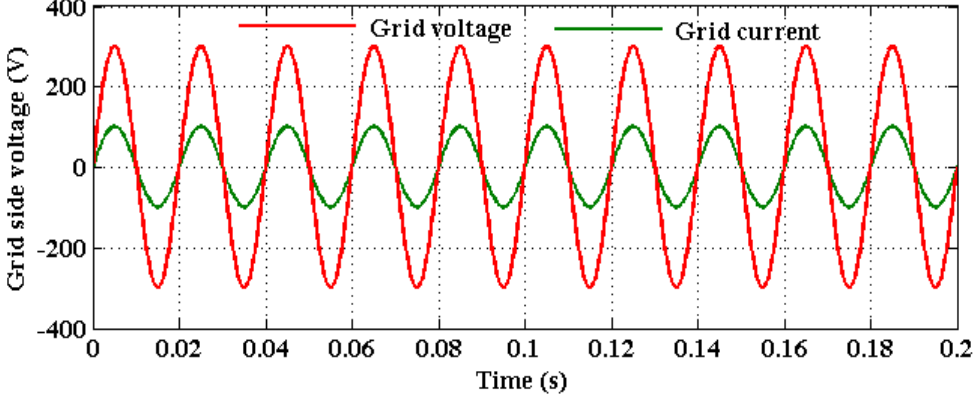
Figure 17. Grid voltage and current.